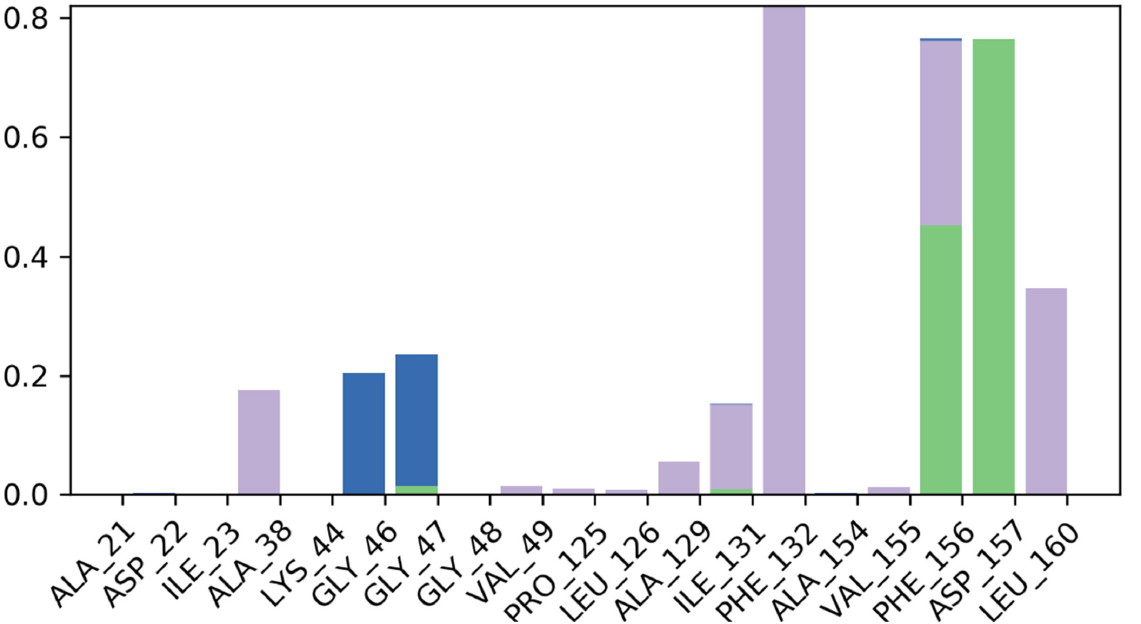
Figure 6. Detailed interactions detected between the ligand guggulsterone with the viral ARP enzyme during 100 ns MD simulation. Hydrophobic interactions are represented in purple; ionic interactions are represented in pink; hydrogen bonds are represented in green; and water bridges are represented in blue.